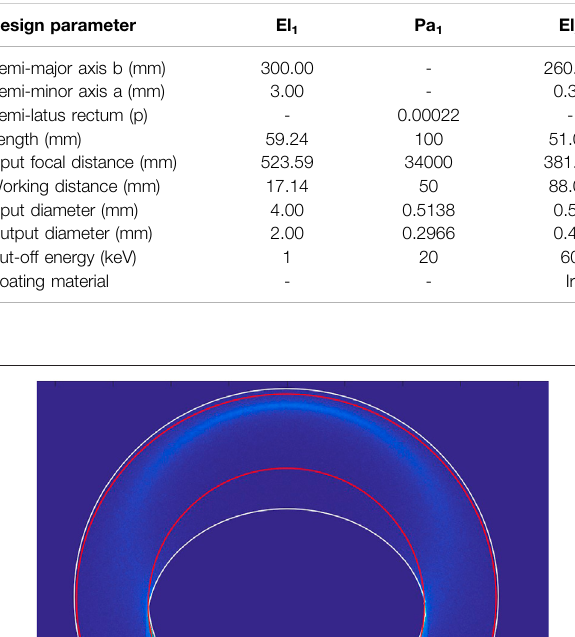
TABLE 2 | Design parameters of SBCs.